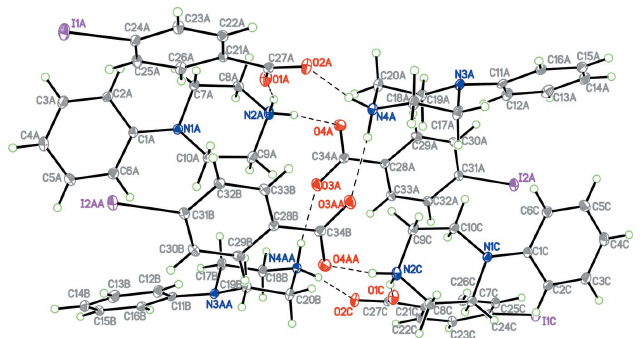
Figure 16 Packing diagram for 5 showing how the R 4